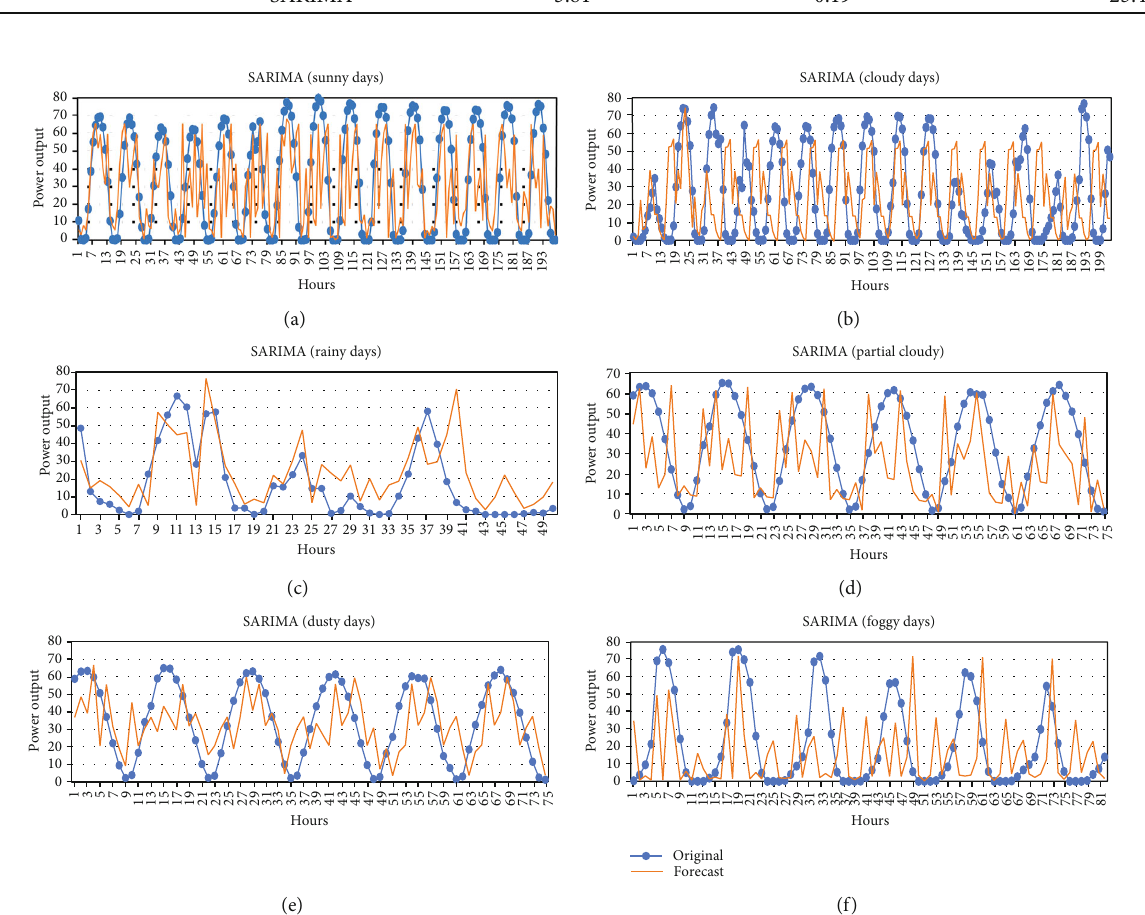
Figure 6: SARIMA results for (a) sunny days, (b) cloudy days, (c) rainy days, (d) partial cloudy days, (e) dusty days, and (f) foggy days.